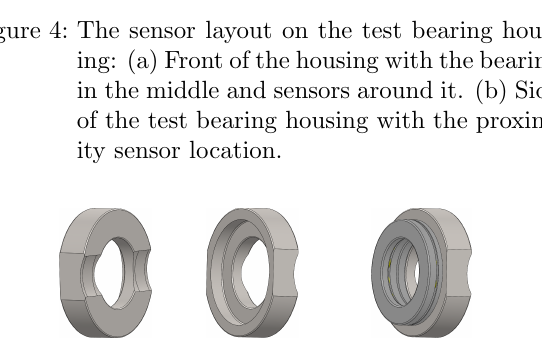
Figure 3: Bearing housings as placed on the shaft. positions.